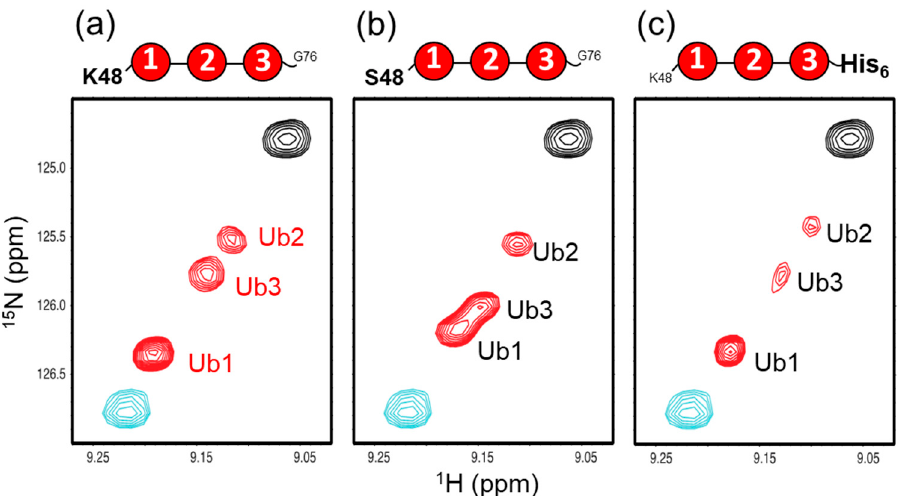
Figure 7. 1 H- 15 N HSQC peaks originating from Val70 of uniformly 15 N-labeled ( a ) wild-type n-triUb, ( b ) K48S-triUb, and ( c ) n-triUb-His 6 . The peaks from monomeric Ub and c-diUb are shown in cyan and black, respectively.